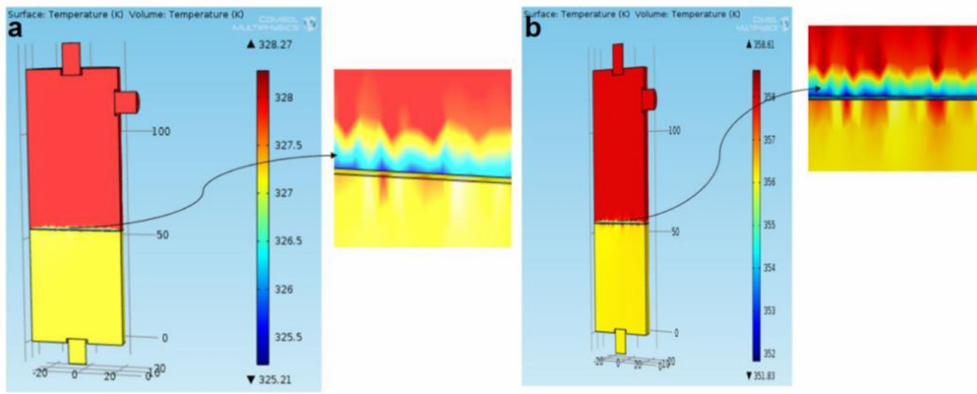
Figure 5. Temperature contour inside membrane module [16]. Reproduced with permission from Elsevier, 2020. (Flow rate = 5l pm, Vacuum degree = 750 mmHg, Initial dye concentration = 30 ppm); ( a ) at 55 ◦ C feed temperature; ( b ) at 85 ◦ C feed temperature.